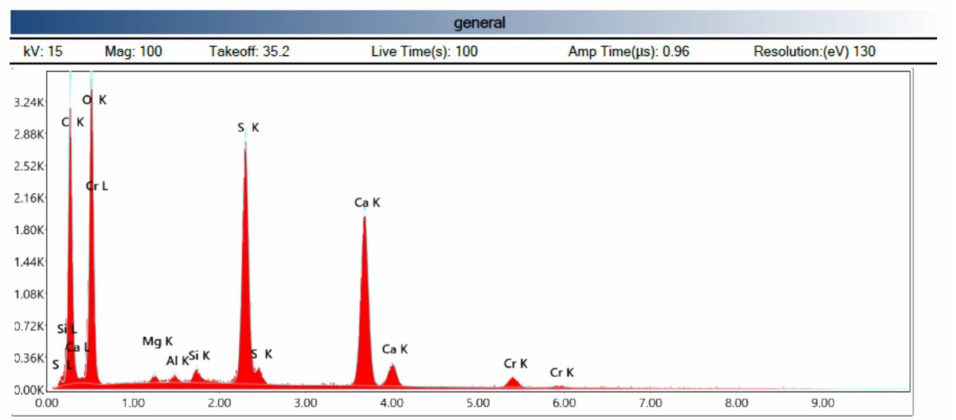
Figure 12. Spectrography of the chemical composition (Source: the